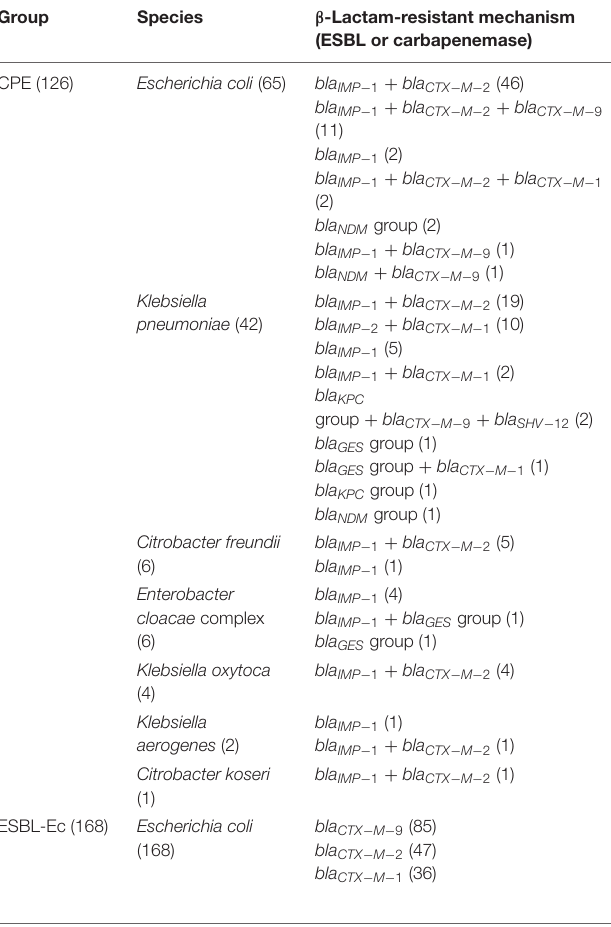
TABLE 1 | Characteristics of carbapenemase-producing Enterobacteriaceae and ESBL-producing Escherichia coli used in this study. Group